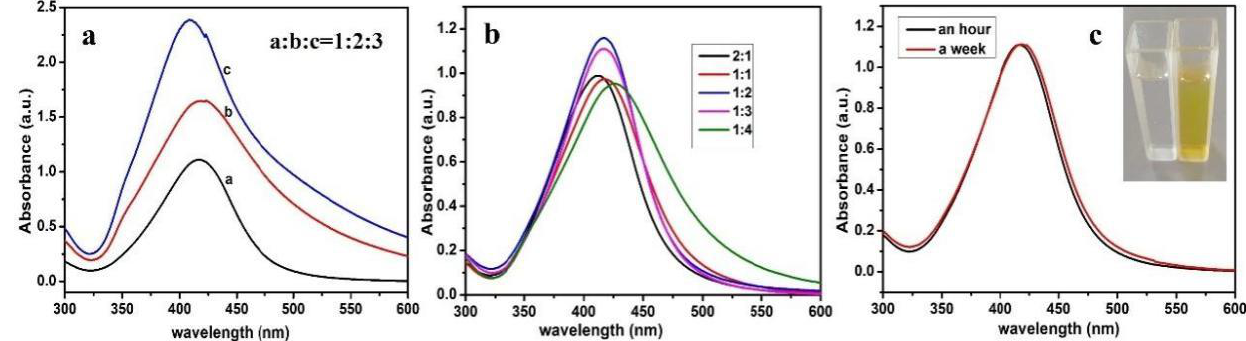
Figure 1. UV – VIS spectra of CMS/PVP-Ag NPs Colloidal Solution: ( a ) Different volumes of AgNO 3 (0.1 M), ( b ) Different molar ratio of AgNO 3 to glucose, and ( c ) The stability of the molar ratio of AgNO 3 to glucose (1:3).